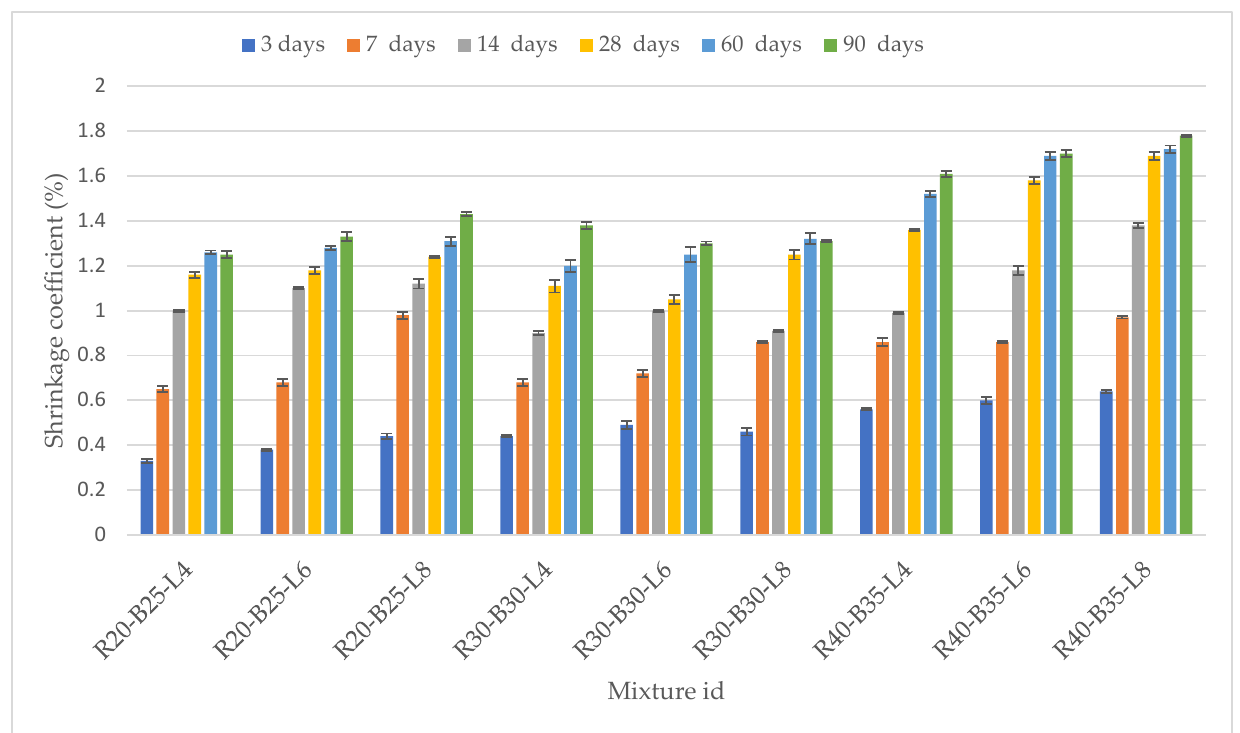
Figure 7. Changing the coefficient of linear expansion of composite samples.